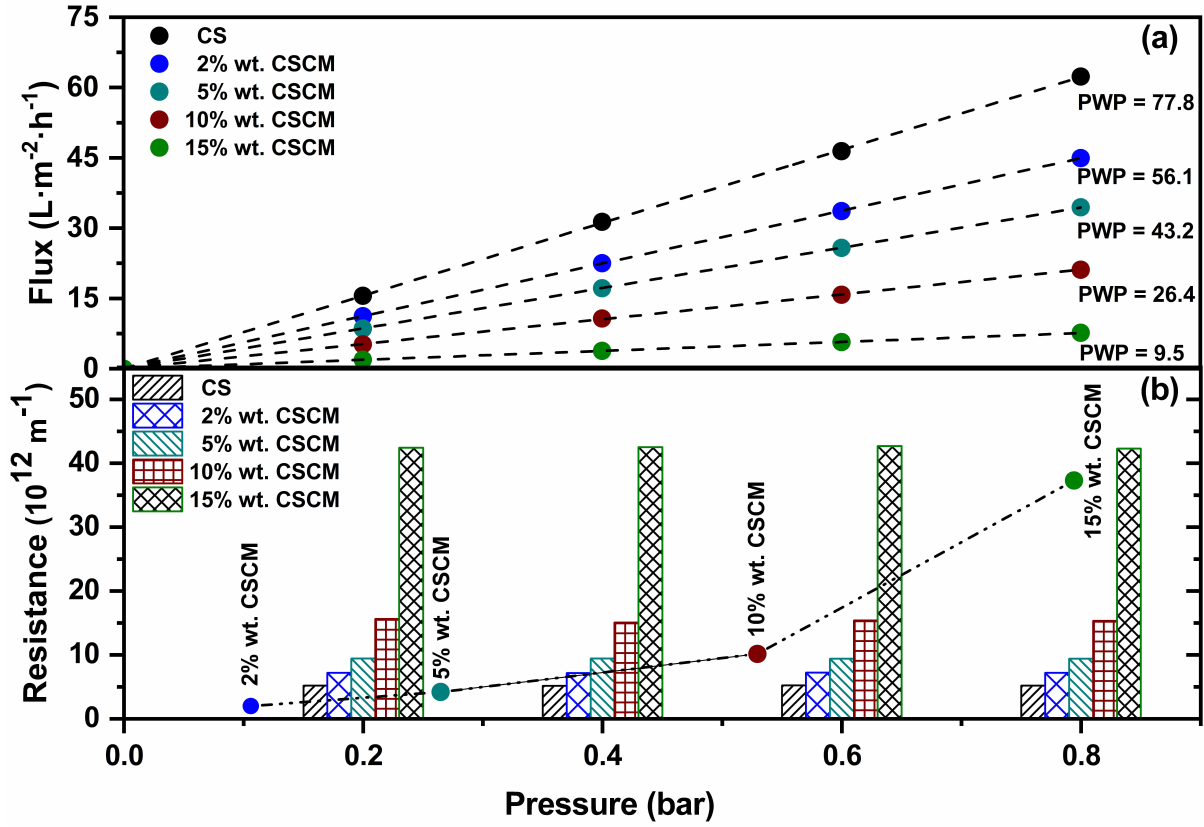
Figure 4. Variation of ( a ) pure water flux and ( b ) resistance of CS and CSCM at 25 ◦ C. Overall resistance is displayed as a bar chart, and the line graph illustrates the resistance of the coated carbon layer. PWP in L · m − 2 · h − 1 · bar − 1